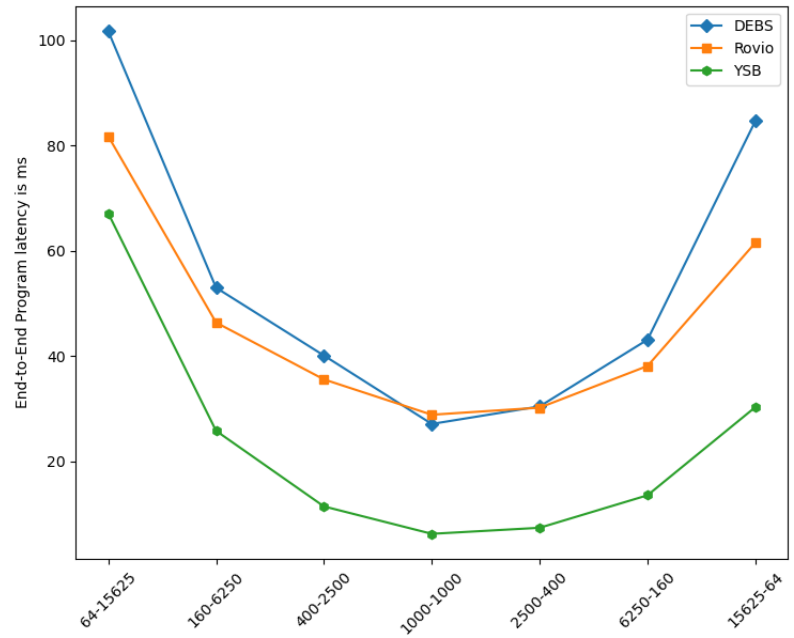
Figure 7. Effect of Partition Matrix